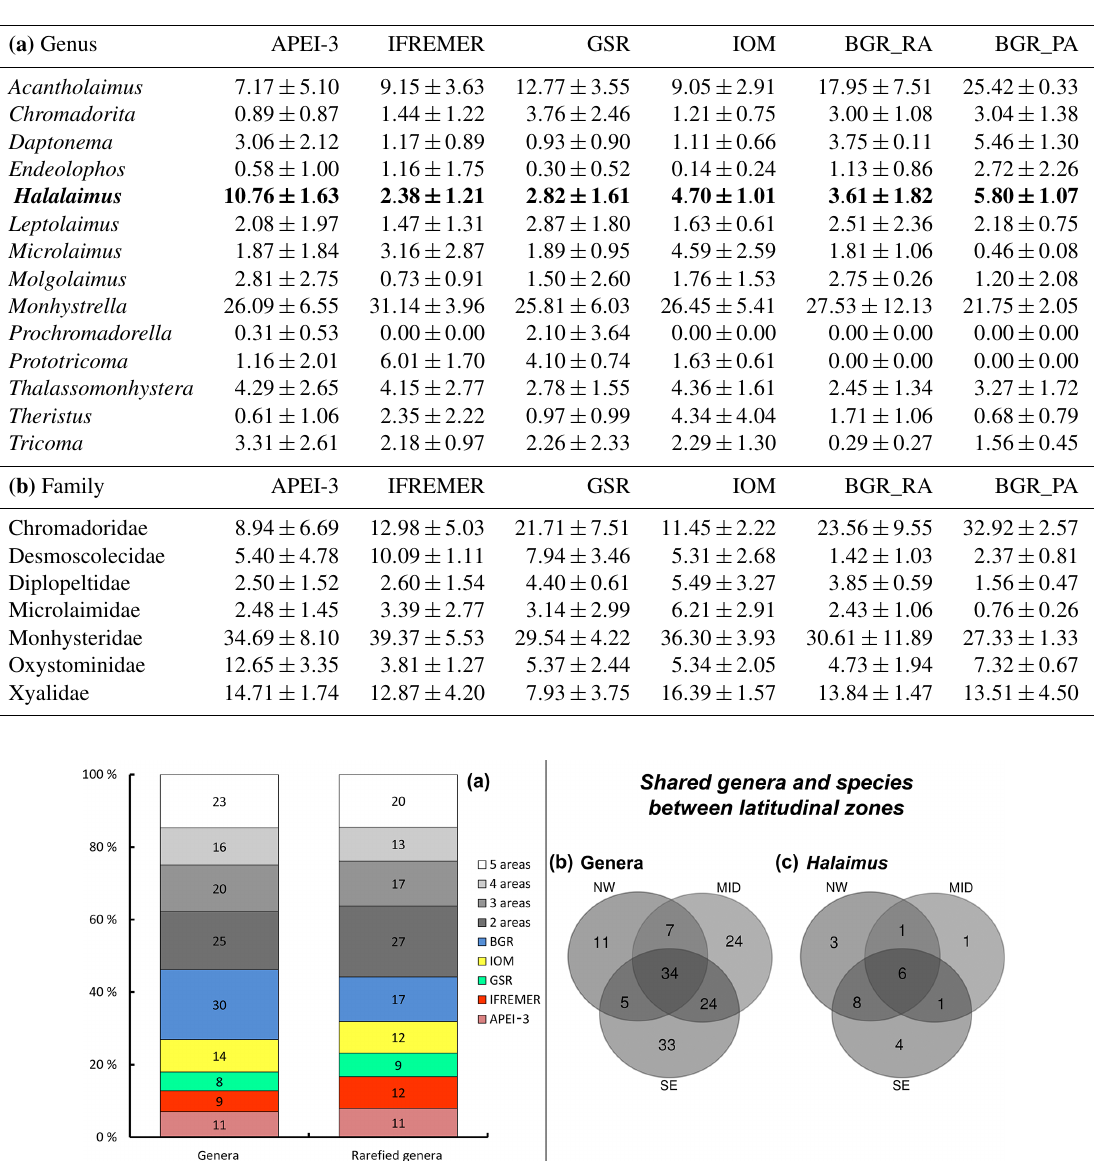
Figure 3. Geographical distribution of genera and Halalaimus species. (a) Number of shared genera between the different areas and their rel- ative contribution to totals based on original count data as well as rarefied genus numbers. Note that BGR_RA and BGR_PA were considered to be one area in this case. Values along the y axis represent the relative contribution of unique and shared genera, while the number indicated in each bar represents the absolute count. (b) Partitioning of genera between latitudinal zones (NW = APEI-3; MID = IFREMER + GSR; SE = IOM + BGR). Genus numbers based on rarefied counts. (c) Partitioning of Halalaimus species between latitudinal